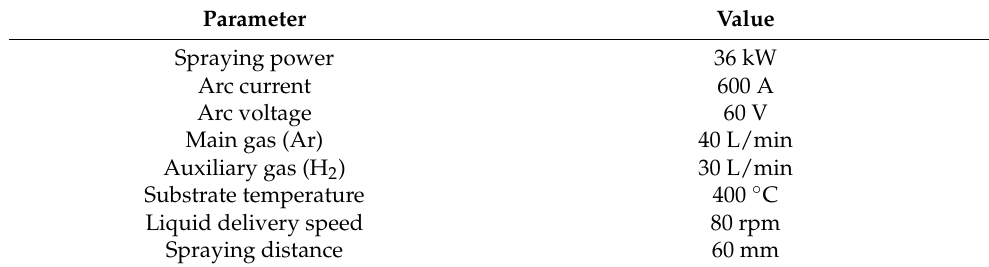
Table 1. The SPPS spraying process parameters.